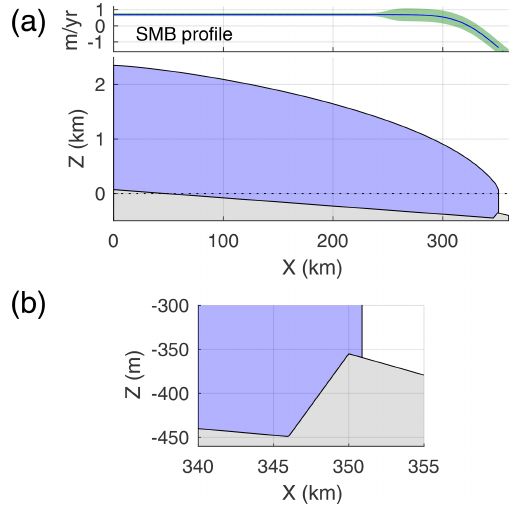
Figure 1. (a) An idealized marine-terminating glacier, whose steady-state terminus position is approximately 1km from a bed peak. SMB profile is shown on top; shading shows the magnitude of variability (1 σ ). (b) Close-up of the bed peak.